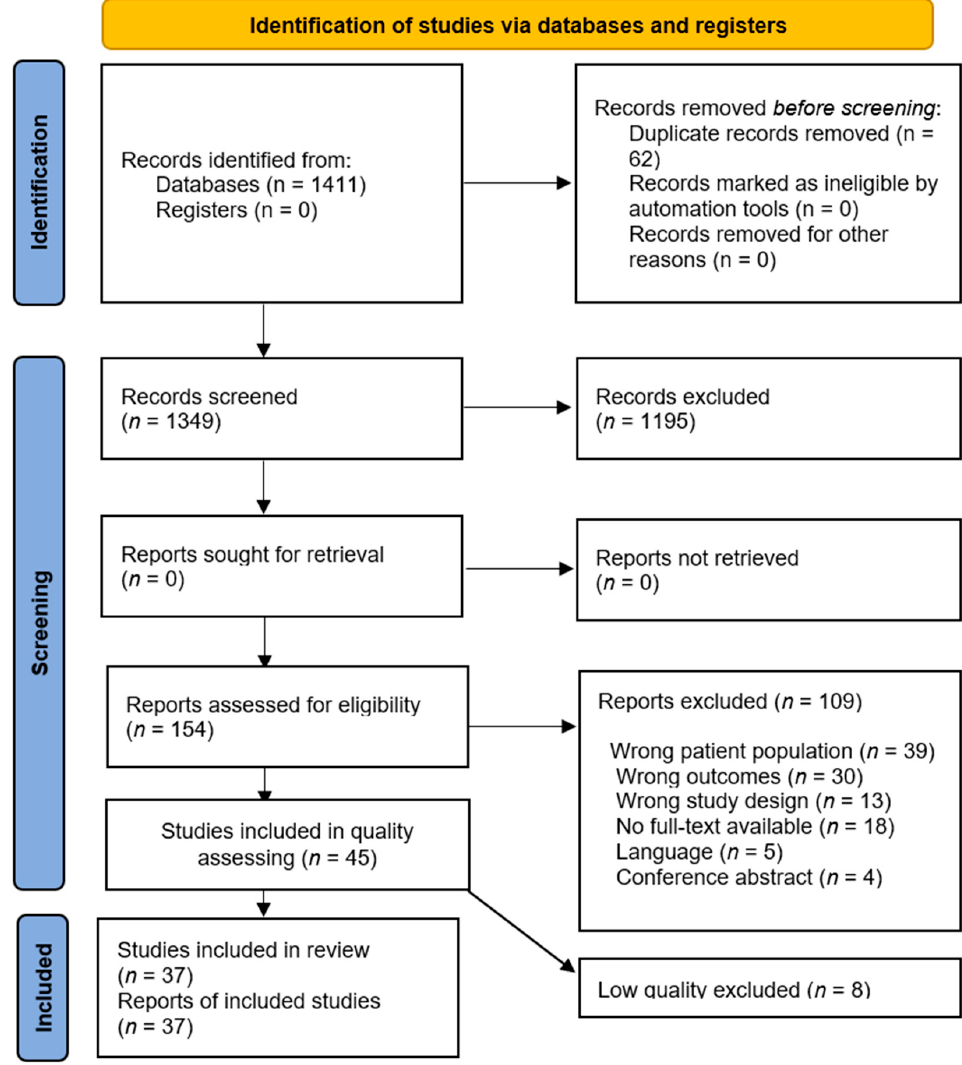
Figure 1. PRISMA flow diagram used to record the selection process in the current research.